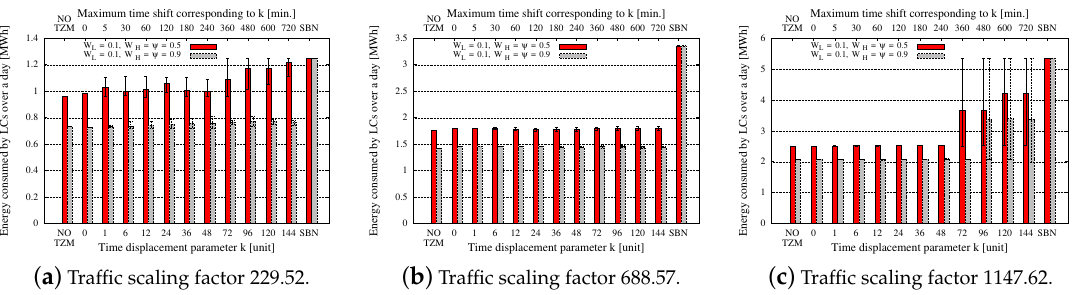
Figure 9. Average energy consumed by all LCs over a day over all SVMs in the Abilene-based network using two EWA settings. The error bars indicate the minimum and maximum values over all